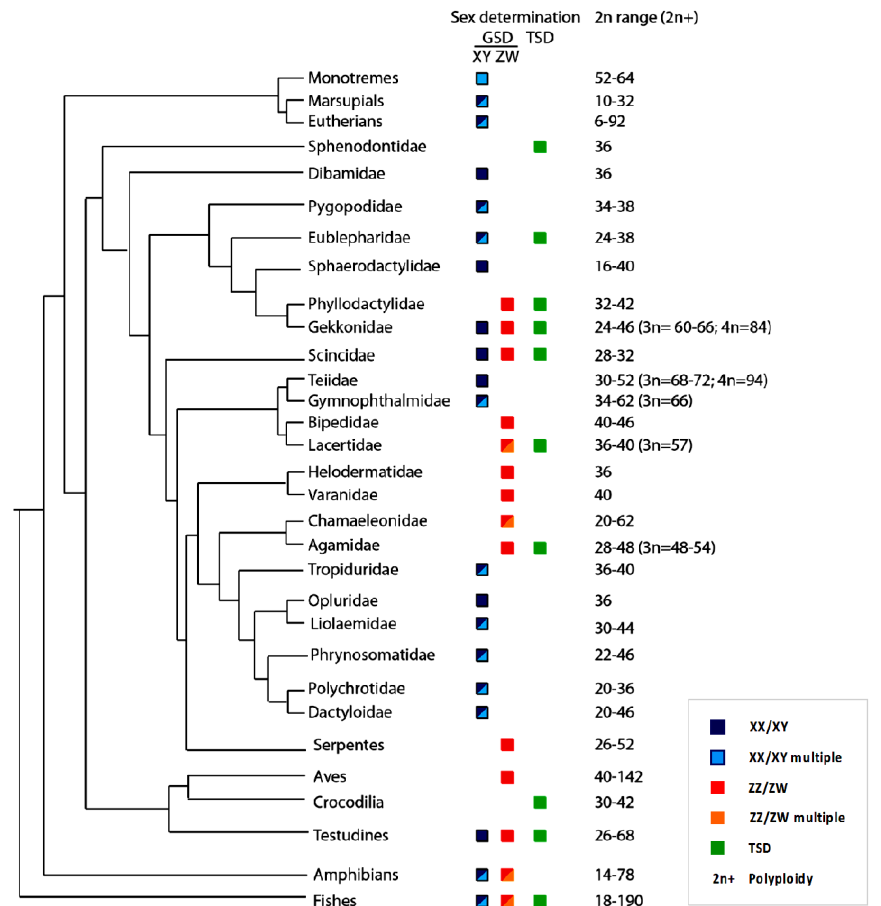
Figure 1. Truncated phylogeny (not according to scale) showing modes of sex determination and number of chromosomes in major lineages of vertebrates, with a particular emphasis on major families of lizards where modes of sex determination and sex chromosome systems are known and show high diversity. This figure includes only those lizard families where sex chromosomes have been identified cytogenetically. Adopted from [6,62,107–117] and references therein.